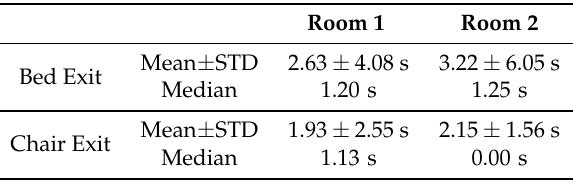
Table 3. Delay in recognition of bed and chair exit. Time in